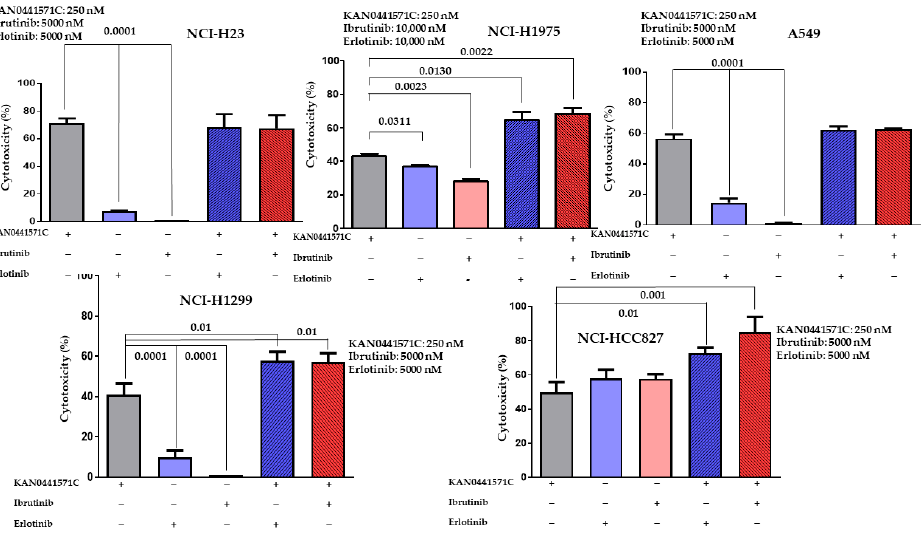
Figure 6. Cytotoxicity (MTT) (mean ± SEM) of five lung cancer cell lines incubated with KAN0441571C in combination with ibrutinib or erlotinib. Results of 3 independent experiments are shown. The concentration of the respective drug are shown for each cell line ( − : No inhibitor added, +: inhibitor added). To further assess the efficacy (antagonism, addition, or synergism) of the combina- tions of KAN0441571C/erlotinib and KAN0441571C/ibrutinib on apoptosis, the Chou– Talalay method was applied. The combinations had synergistic or additive apoptotic ef- fect in all tested lung cancer cell lines (Figures 7 and S6A,B).